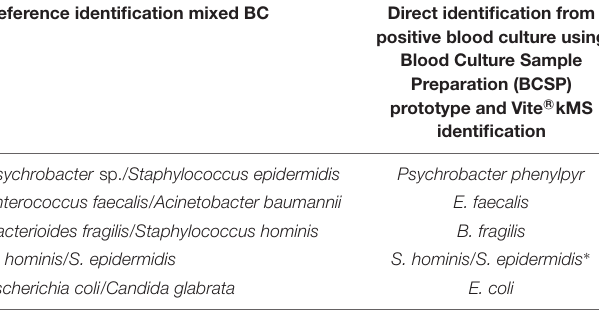
TABLE 4 | Polymicrobial